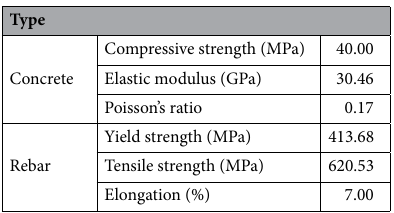
Table 1. Mechanical properties of the concrete and steel rebar used in the tests.